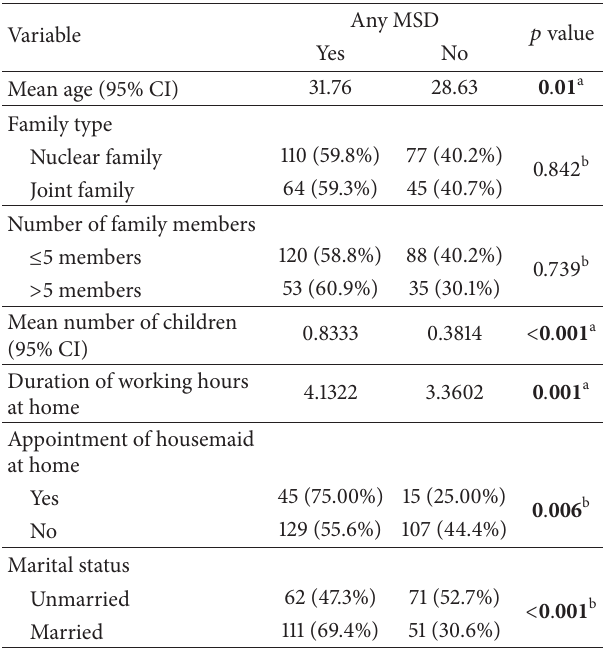
Table 3: Association of MSD with various sociodemographic vari- ables (univariate